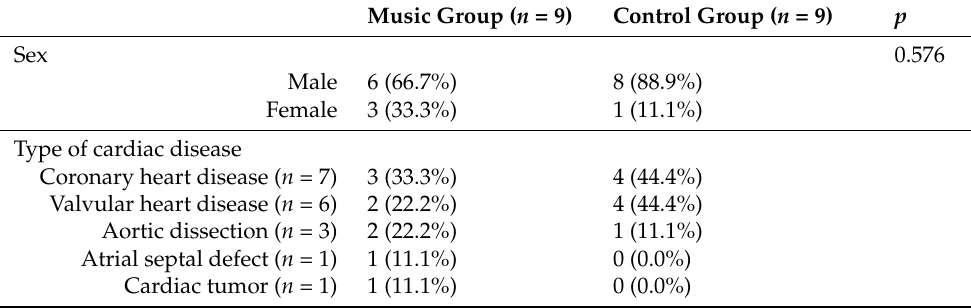
Table 1. Classification of patients undergoing cardiothoracic